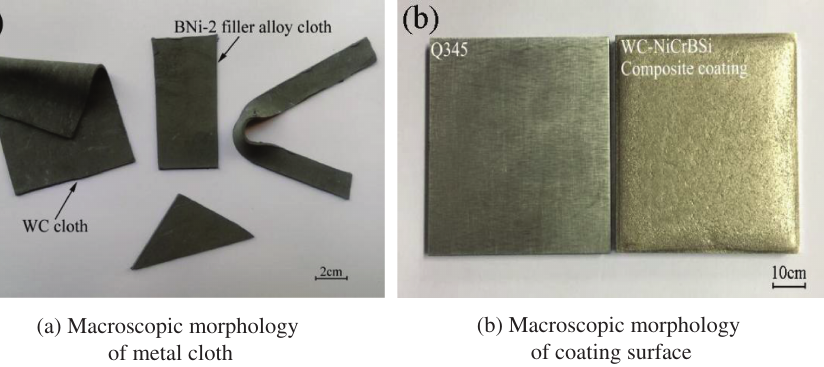
Figure 1: macroscopic morphology of metal cloth and coating surface:(a) macroscopic morphology of metal cloth, (b) macroscopic morphology of coating surface.